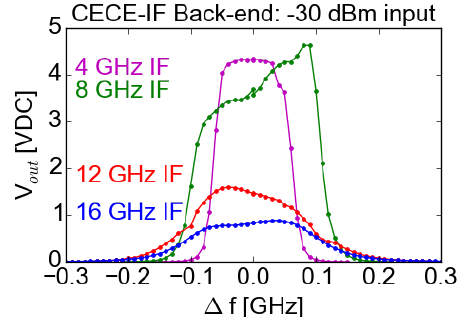
Fig. 5. Response of each CECE-IF channel to -30 dBm input.